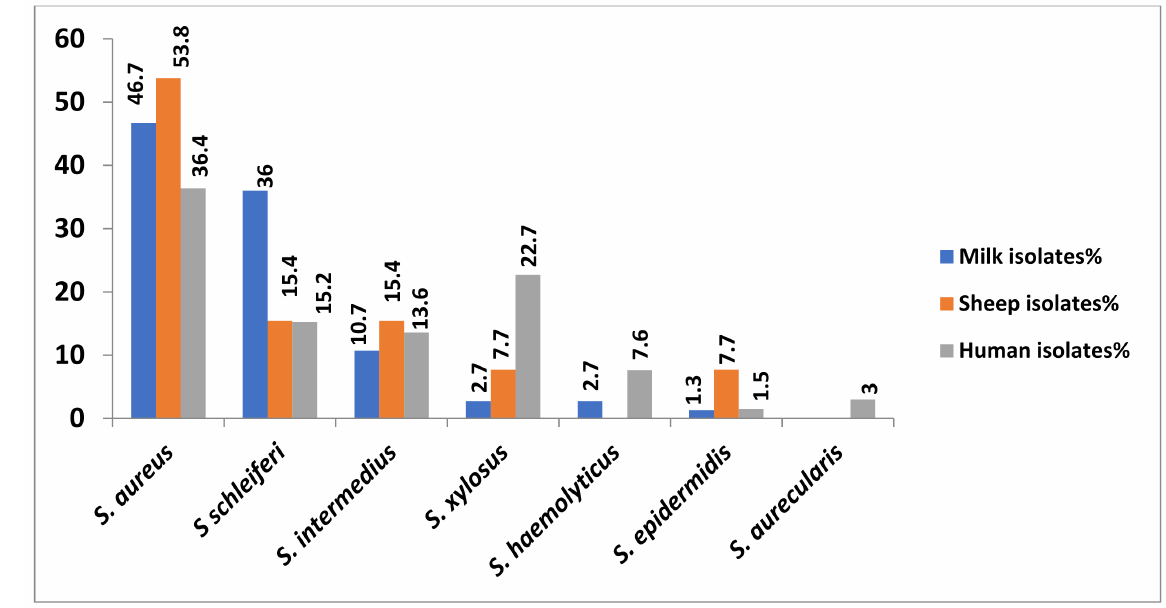
Figure 2. Prevalence of Staphylococcus spp. in different examined